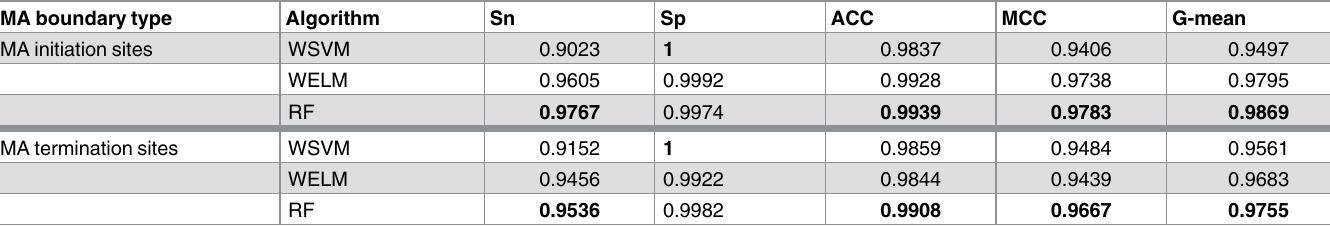
Table 1. Prediction performance of models applying different